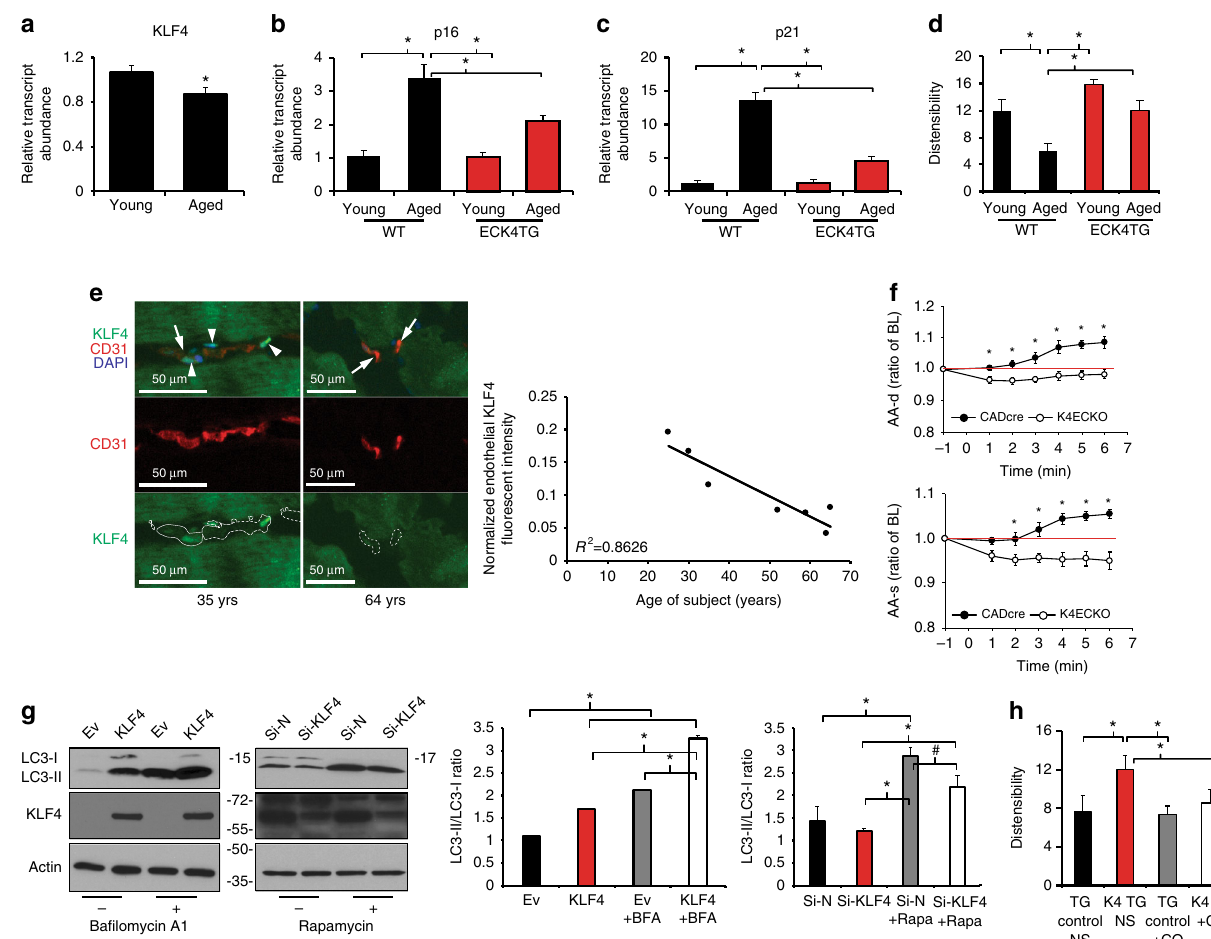
Fig. 5 KLF4 regulates autophagy and aging in vasculature and decreases with age. a qPCR analysis of Klf4 in isolated cardiac endothelial cells in young and middle-aged wild-type mice. (Young = 3 months, middle-aged = 10 – 12 months, N = 3 biological replicates). * P -value < 0.05 by Student ’ s T -test. qPCR analysis of p16 ( b ) and p21 ( c ) in isolated cardiac endothelial cells in young and aged wild-type and ECK4TG mice (young = 3 months, aged = 10 – 12 months, N = 3 biological replicates). * P -value < 0.05 after one-way analysis of variance followed by the Tukey ’ s post hoc test. d Ascending aorta dilation at baseline in young and aged transgenic control and ECK4TG mice (young = 3 months, aged = 10 months, N = 6 – 9). * P -value < 0.05 after one- way analysis of variance followed by the Tukey ’ s post hoc test. e Expression of CD31 and KLF4 by immuno fl uorescence, with DAPI staining, representative images. CD31-positive areas are marked by dotted lines . Arrows indicate CD31-positive endothelial cells. Arrowheads indicate KLF4-positive endothelial nuclei. Scale bar = 50 μ m. Correlation studies were performed with R 2 = 0.8626 (Pearson correlation, P -value = 0.003; N = 7 patients). Further details are given in Methods section. f Ascending aorta diastolic (AA-d) and systolic (AA-s) diameter in control (CADcre, N = 6) and Klf4 endothelial knockout (K4ECKO, N = 9) mice before and during acetylcholine infusion ( t = 0). Diameter assessed by M-mode echocardiography. Ratio of baseline (Ratio of BL). * P -value < 0.05 by Student ’ s T -test. Further details are given in Methods section. g Western analysis of HUVECs overexpressing KLF4 with and without BFA treatment with knockdown of KLF4 in rapamycin treated HUVECs. Brie fl y, HUVECs were treated with adenoviral KLF4 or siRNA targeting KLF4 and effects assessed by western blot 2 days afterwards. Data shown are representative of two independent experiments. Graphs represent quantitated LC3-II/LC3-I ratios. * P -value < 0.05, # P -value < 0.1 after one-way analysis of variance followed by Tukey ’ s post hoc test. Further details are given in Methods section. h Administration of chloroquine in middle-aged mice to inhibit autophagy and measurement of ascending aorta dilation in middle-aged transgenic control and ECK4TG mice (aged = 10 – 12 months, NS = normal saline, CQ = chloroquine, N = 6 – 9). * P -value < 0.05, after one-way analysis of variance followed by the Tukey ’ s post hoc test. All error bars represent standard error of the mean